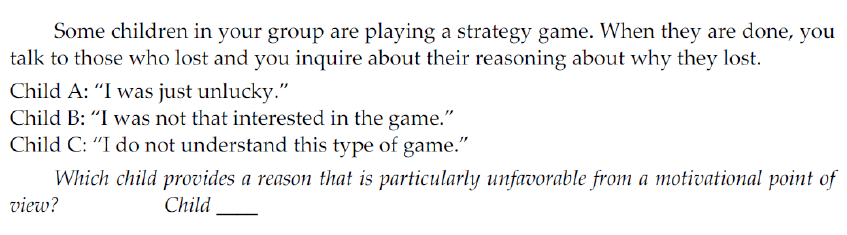
Figure A3. Example item from the GPK assessment (translated).